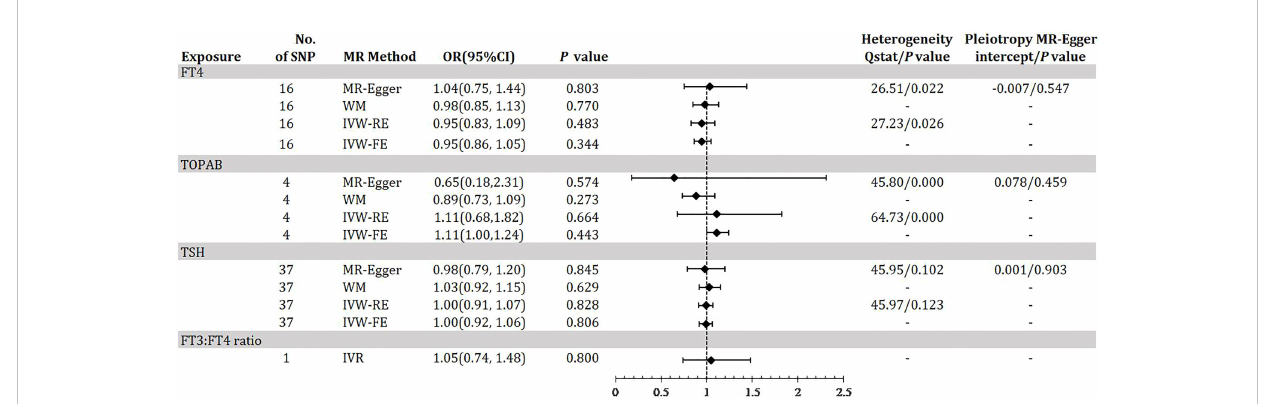
FIGURE 3 Odds ratio for association of genetically predicted thyroid function with DR. FT4, free thyroxine; FT4, free thyroxine; FT3, free triiodothyronine; TSH, thyroid-stimulating hormone; TPOAB, thyroid peroxidase antibodies; DR, diabetic retinopathy; CI, con fi dence internal; OR, odds ratio; IVW-FE, inverse-variance weighted fi xed-effects MR; IVW-RE, inverse-variance weighted random-effects MR; MR, mendelian randomization; WM, weighted median; IVR, instrumental variable ratio (Wald) estimator; SNP, single-nucleotide polymorphism. P value for heterogeneity based on Cochran ’ s Q statistic for IVW, and Rücker ’ s Q for MR-Egger.